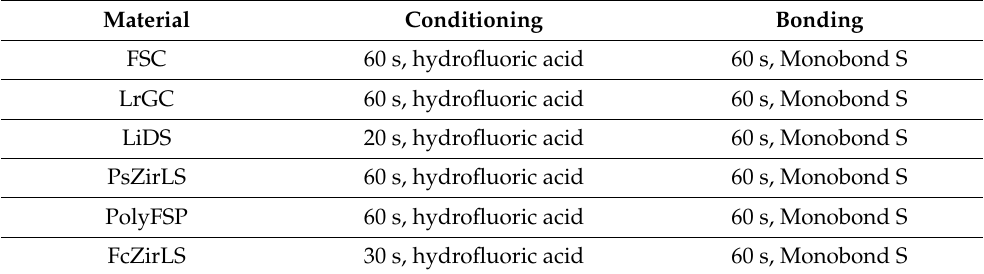
Table 2. Conditioning of the ceramic material.